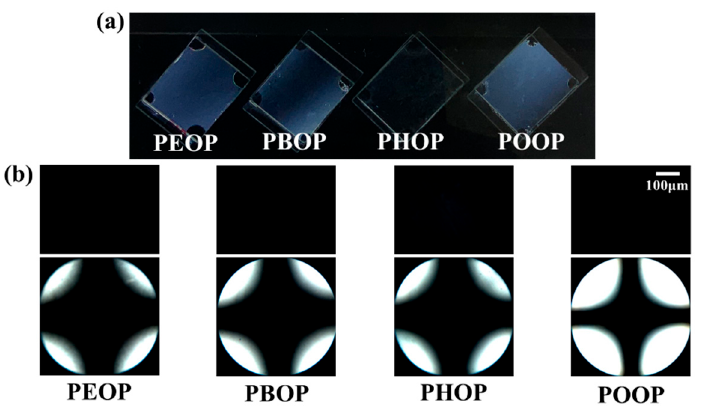
Figure 4. ( a ) Photograph, ( b ) orthoscopic (top) and conoscopic (bottom) polarized optical microscopy (POM) images of the LC cells fabricated with PEOP, PBOP, PHOP, and POOP films. In addition, we observed the orientation behavior of the LC molecules in PEOP# cells, using 5CB to investigate the effect of the molar content of the 4-ethyloxyphenoxymethyl side group in the polymer. Figure 5a shows the photographs of the LC cells made from PEOP# and PEOP. The PEOP20 LC cells exhibited LC textures with birefringence, while good uniformity of vertical LC orientation was observed for PEOP40, PEOP60, PEOP80, and PEOP in the whole area. Additionally, LC orientation behaviors of the LC cells fabri- cated with the PEOP# films were investigated by observing their POM images for close